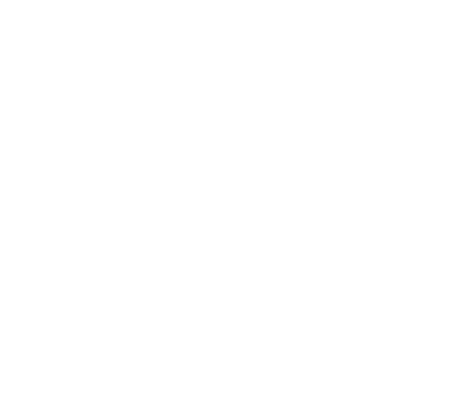
Figure 6. XRD analysis of Zr-4 base material and the joint bonded at 800 °C for 7 MPa under 60 min.